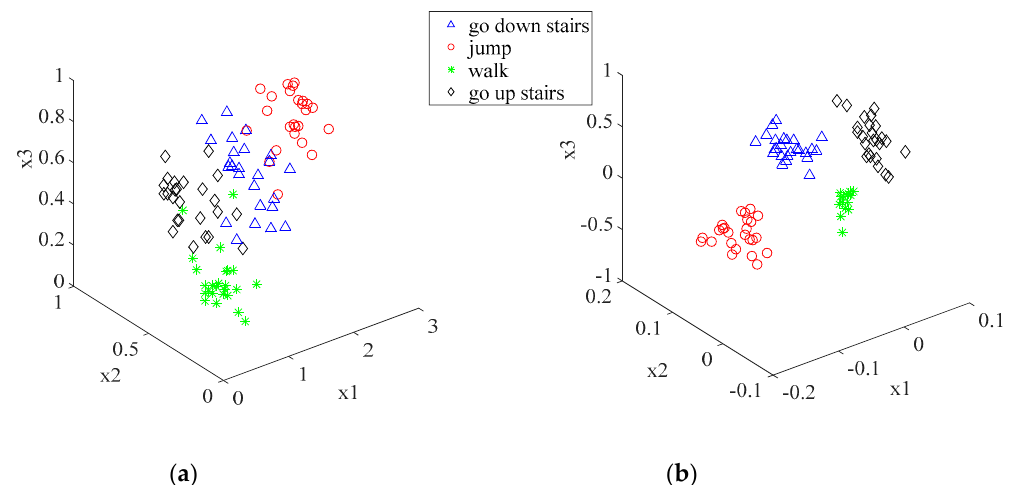
Figure 3. Features without and with kernel Fisher discriminant analysis (KFDA) operations. ( a ) 3D feature space representation on original features (x1 is the mean value of the y -axis, x2 is the standard deviation of the x -axis, x3 is the standard deviation of the y -axis); ( b ) 3D space representation of the first three KFDA-based features.